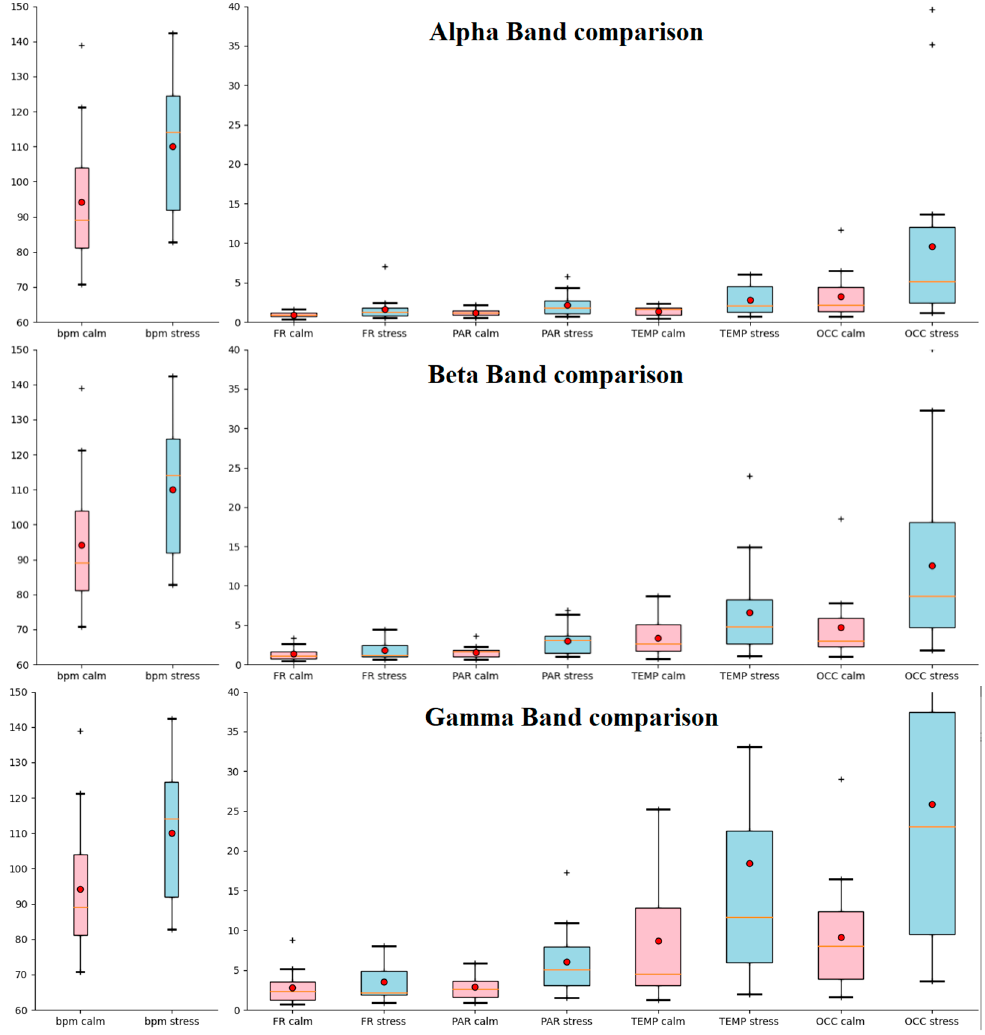
Figure 5. Calm and stressed state comparison of BPM and alpha, beta, and gamma bands. FR represents frontal cortex, PAR represents parietal cortex, TEMP represents temporal cortex, and OCC represents occipital cortex. The “+” sign at the top of the boxplots represents extreme values.